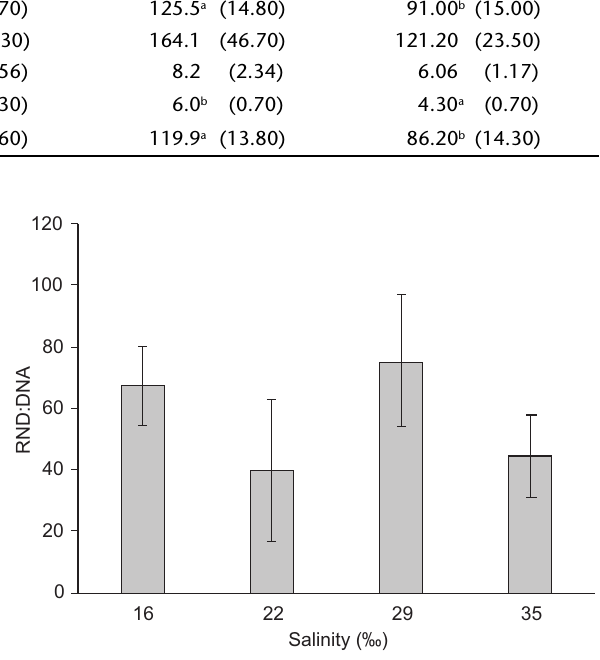
Figure 4. RNA:DNA ratios of F. paulensis postlarvae (PL days of culture in different test salinities (16, 22, 29, and 35‰) at 24.7 ± 1.6°C and,388 ind/m 2 . Vertical bars indicate standard devia- tions. No significant differences were detected (p > 0.05). n = 11.